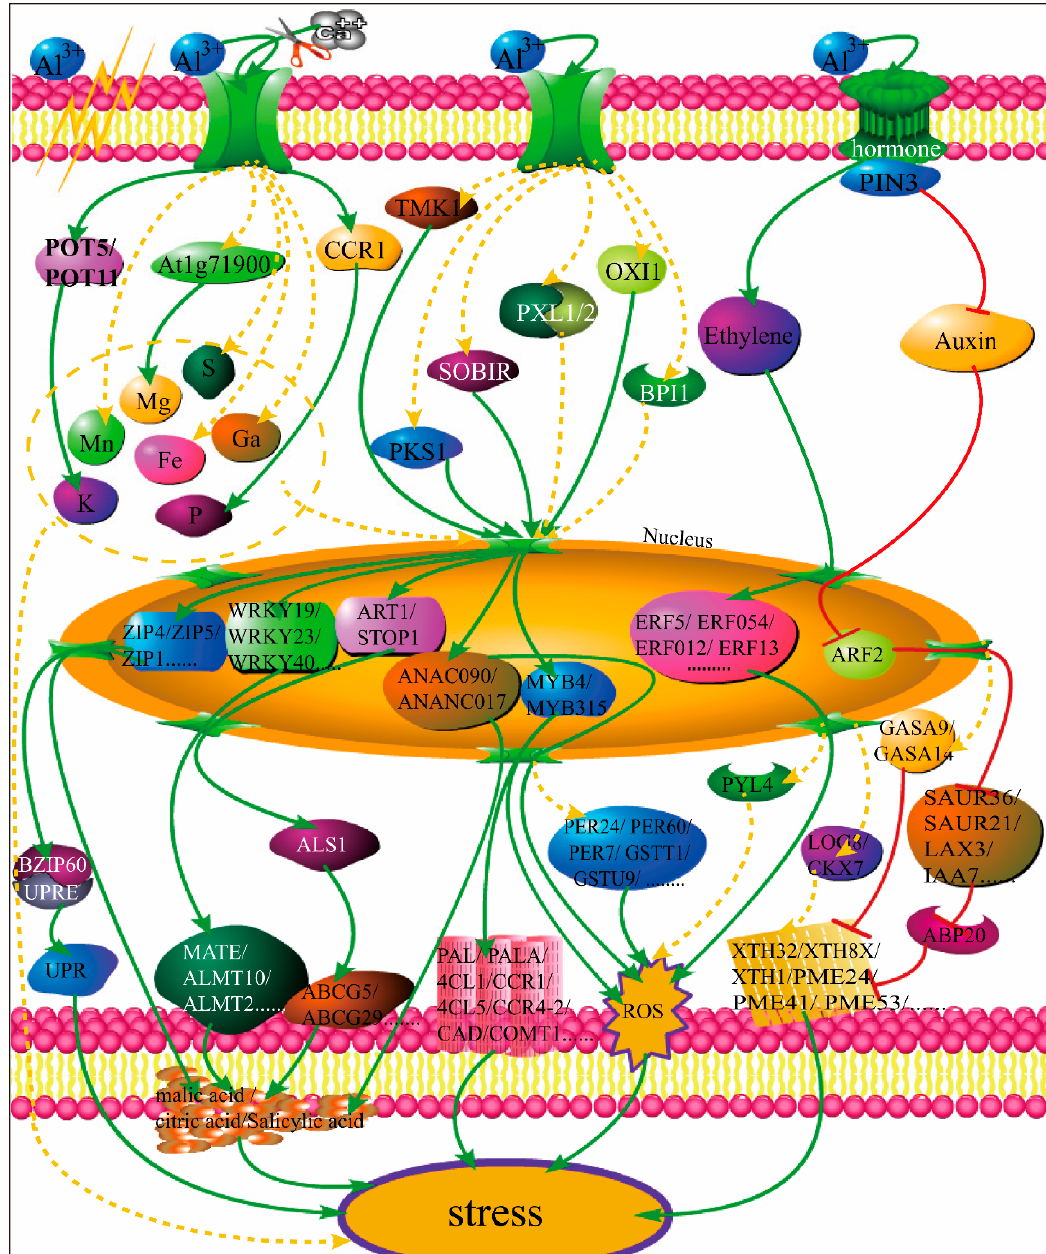
Figure 12. Aluminum stress pathway diagram at the cell level in N. cadamba . The green solid line indicates that the upstream gene regulation activates the downstream gene, the red solid line indicates that the upstream gene regulation suppresses the downstream gene, and the yellow dotted line indicates that the upstream gene indirectly or possibly regulates the downstream gene and responds to stress